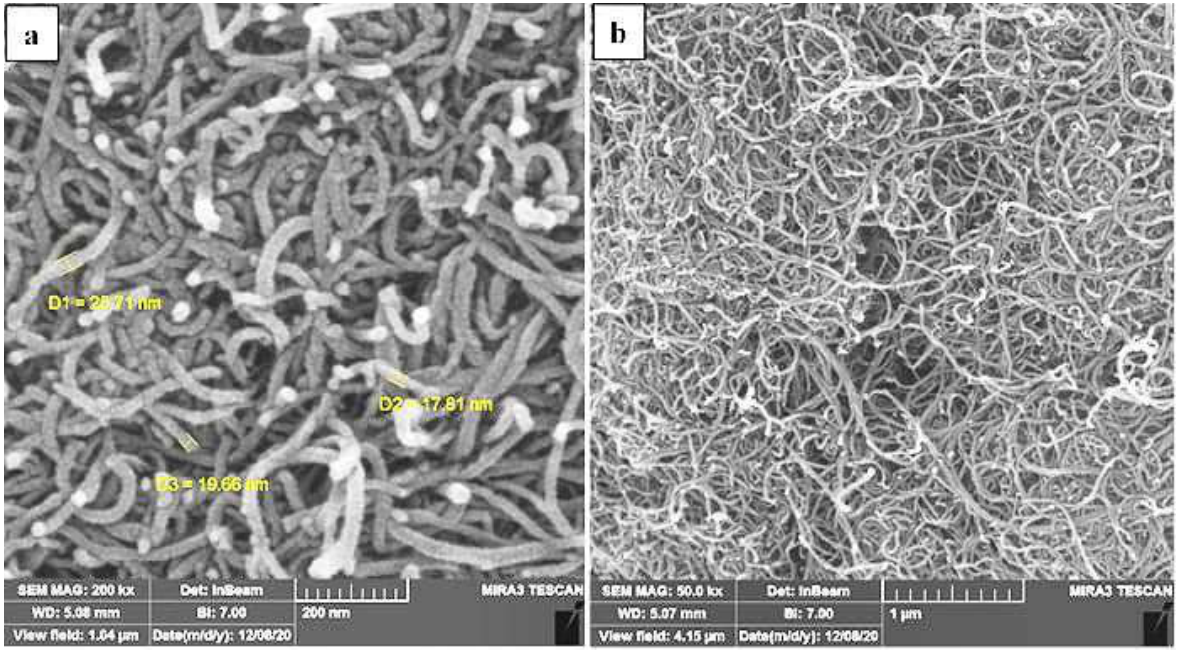
Figure 3: FESEM images of R-MWCNTs with different magnifications at a) scale bar = 200 nm and b) scale bar = 1 μm.